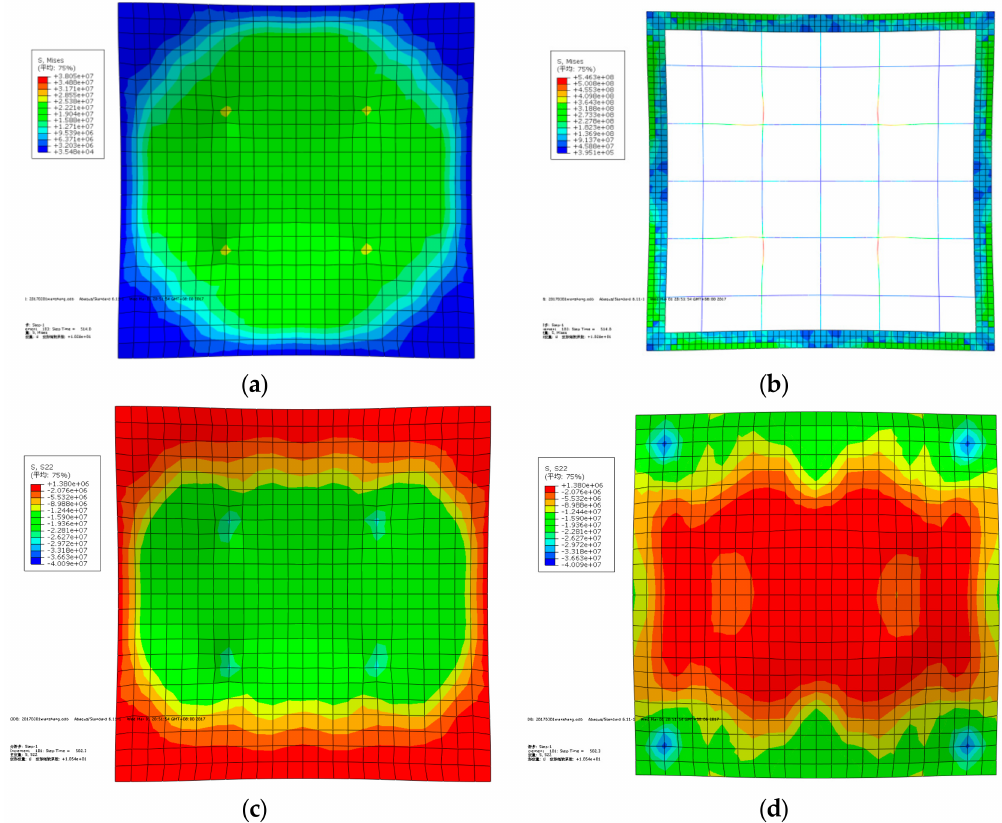
Figure 21. Mises stress contour figures of concrete and steel skeleton (cracked). ( a ) Mises stress in the concrete compression zone; ( b ) Mises stress of the reinforcement skeleton; ( c ) S22 stress in the concrete compression zone; ( d ) S22 stress in the concrete tension zone.